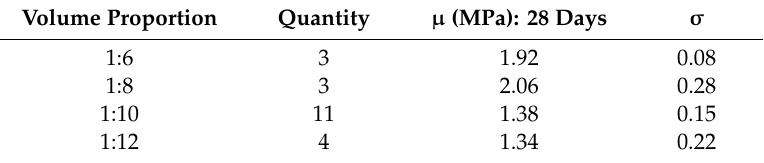
Table 3. Ratio of volume proportions, quantities and compressive strengths of the tested CEBs